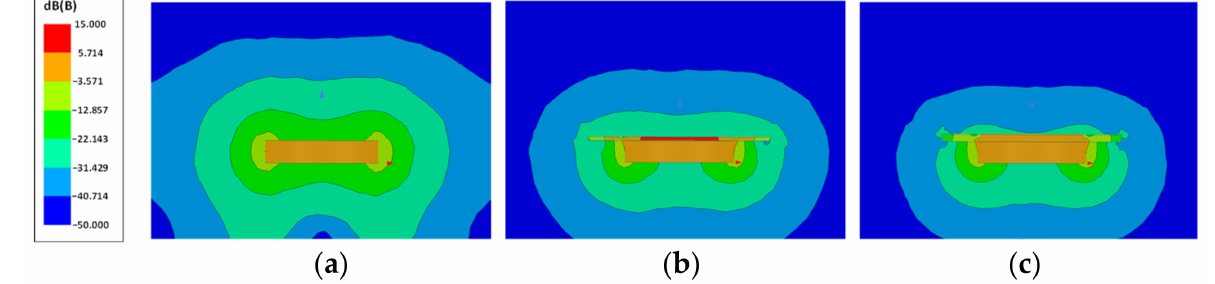
Figure 5. Simulated iso-value mapping of the magnetic flux density of a FMM in the case of ( a ) cylin- drical permanent part alone, ( b ) permanent part coupled with a 0.5 mm-thick ferromagnetic patch, and ( c ) permanent part coupled with a 1.0 mm-thick ferromagnetic